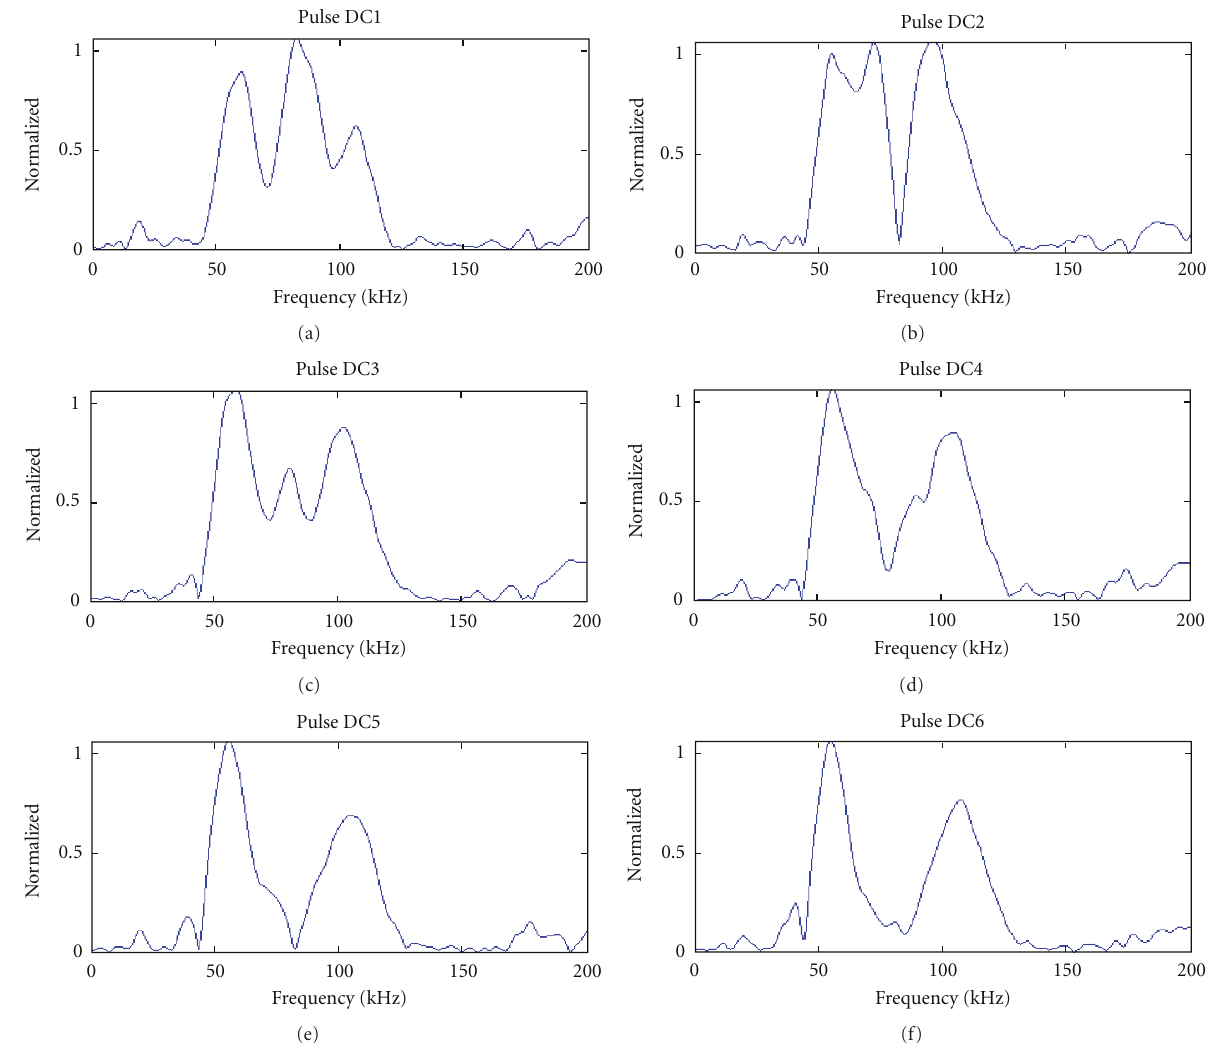
Figure 24: Spectral responses for bare SL17L cable D, pulses DC1–6.